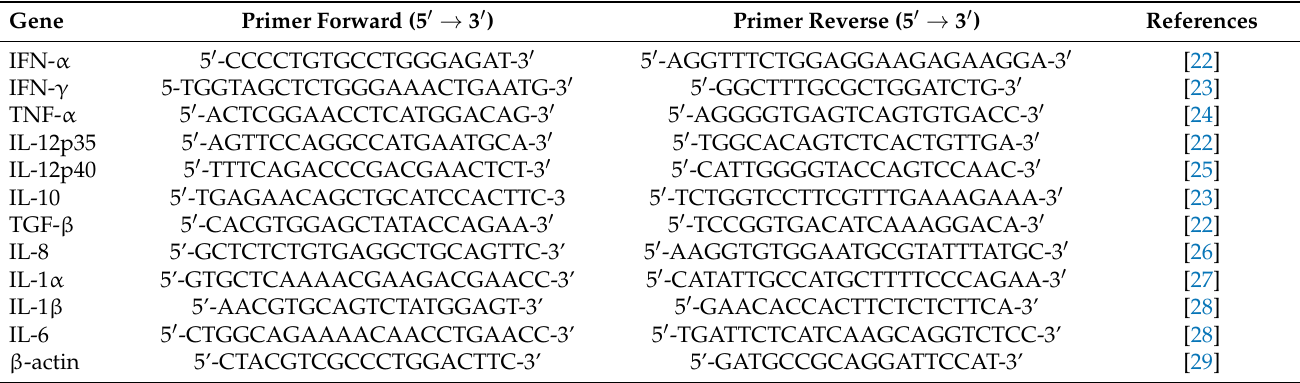
Table 4. Primers for cytokines IL-1 β , IL-6, IL-8, IL-10, IL-12p35, IL-12p40, TNF- α , IFN- α , IFN- γ , and TGF- β and primers for β -Actin.